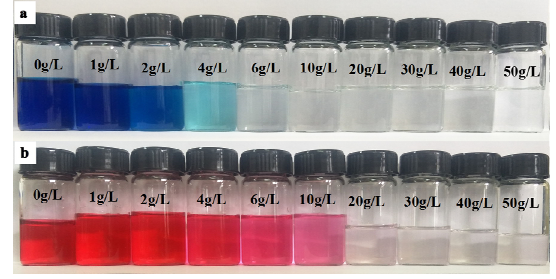
Fig. 9 Photographs of (a) MB and (b) BF solutions treated using different microsphere dosages.